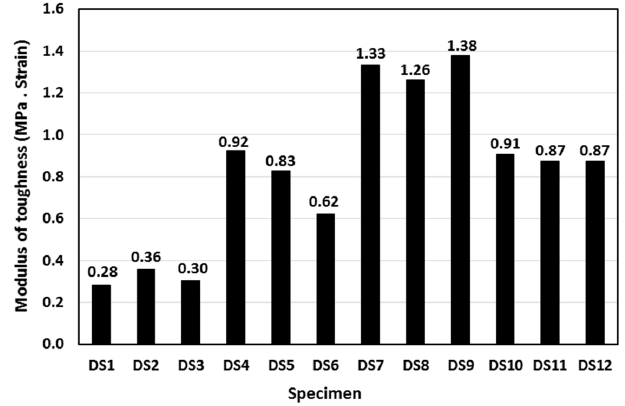
Figure 7. Modulus of toughness.